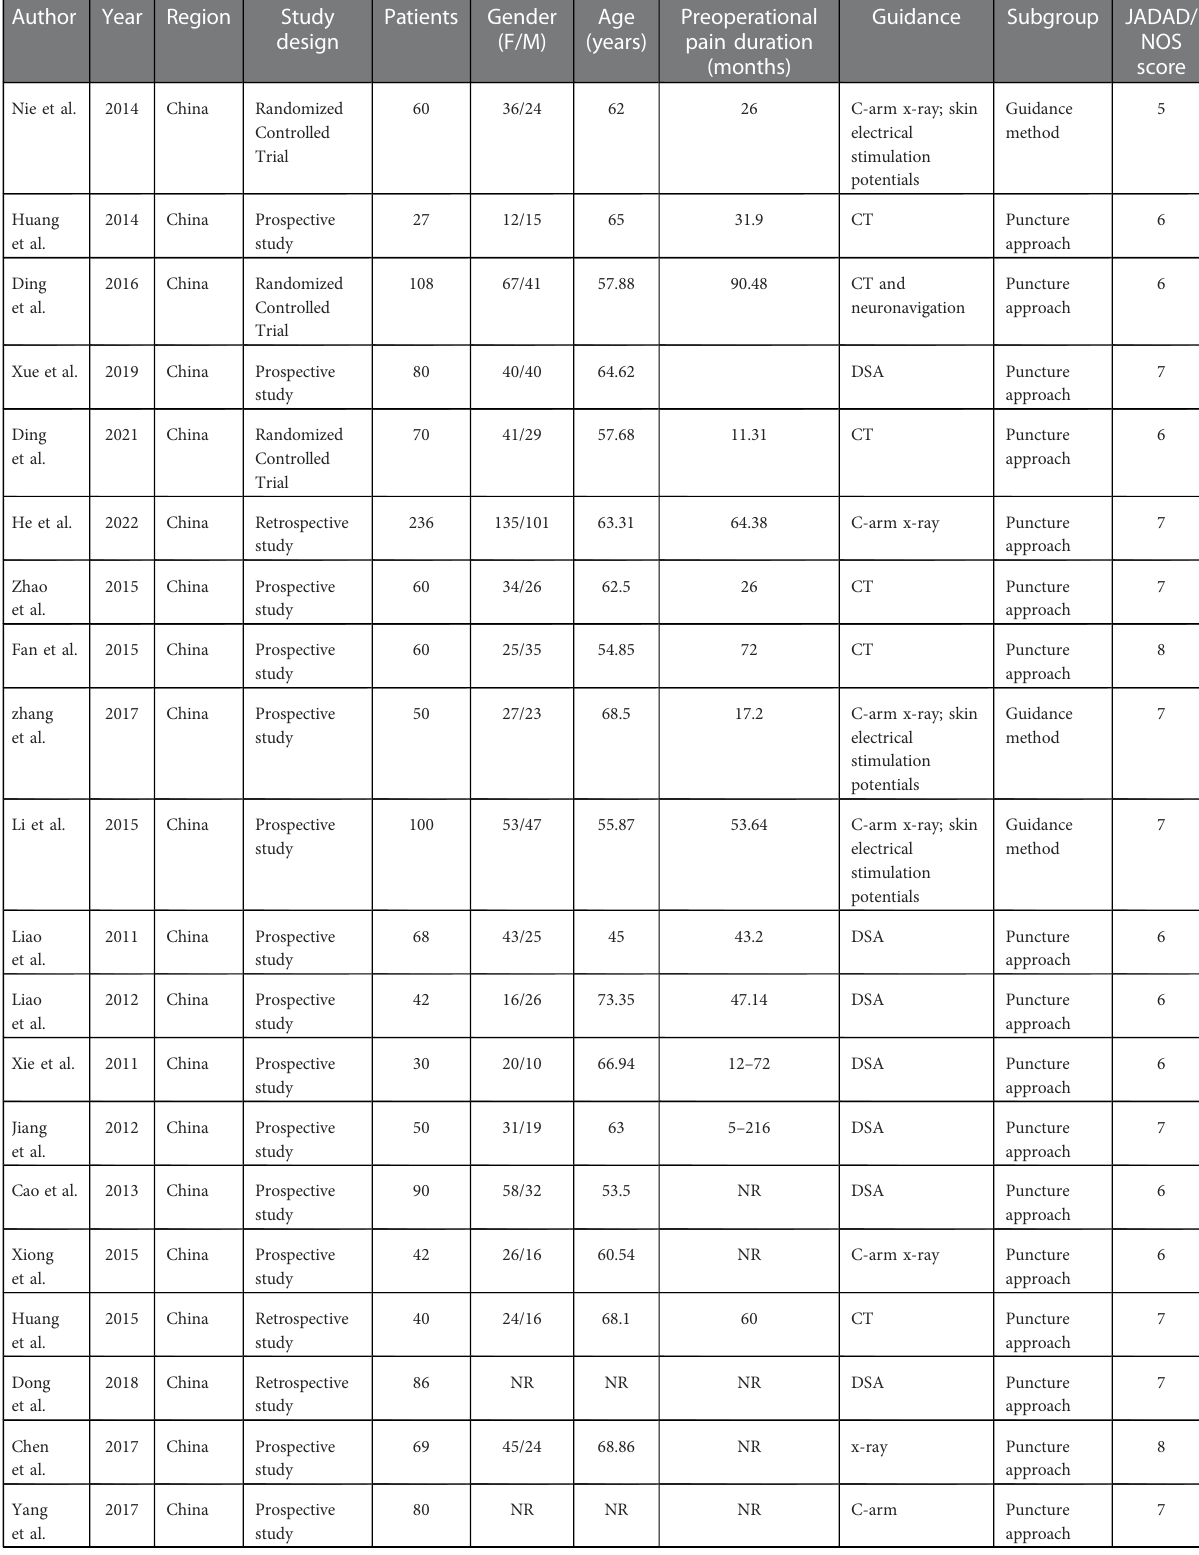
TABLE 1 Characteristics and quality assessment of the 22 included studies.